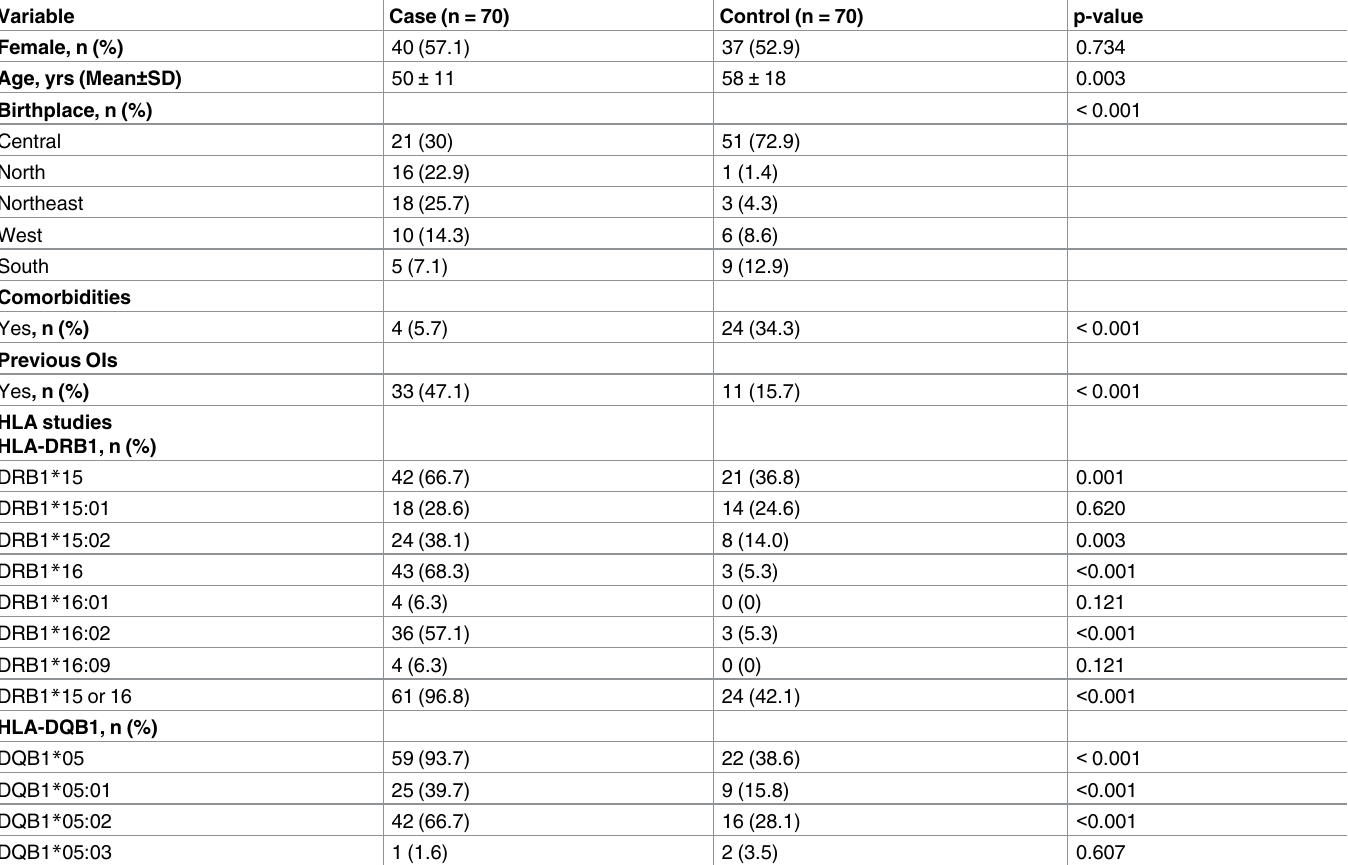
Table 1. Baseline characteristic and genetic